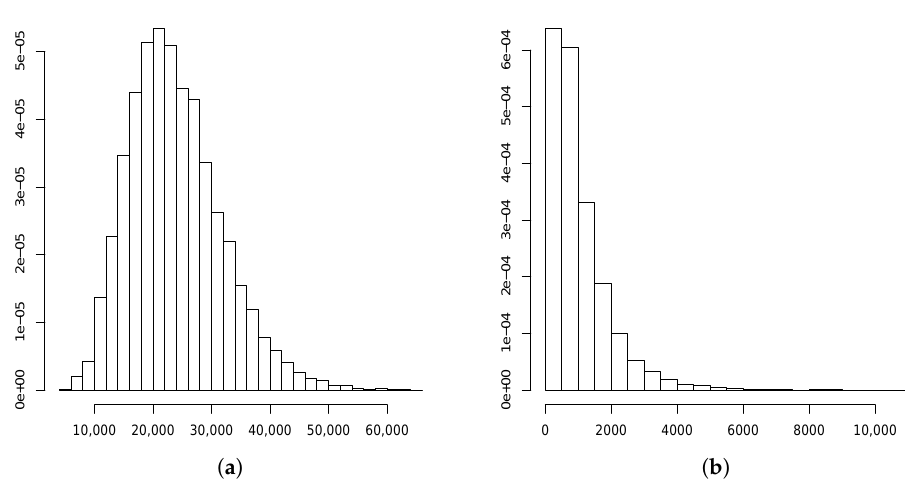
Figure 6. Estimated predictive distributions of Mr 9 |FM 4 ( a ) and MR 9 |FM 4 ( b ).